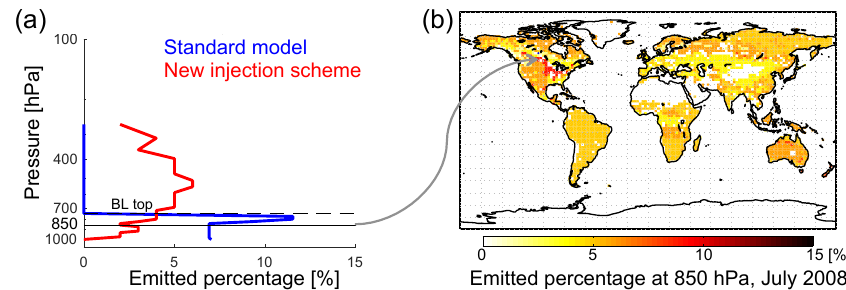
Figure 2. (a) Vertical profile of the percent of emissions in each model level for a sample location over boreal Canada (56 ◦ N, 105 ◦ W) from the public-release version of GEOS-Chem (blue) and the new observationally based injection scheme (red). The dashed line indicates the averaged boundary layer top of this month. The solid black line is at 850hPa, corresponding to the layer shown in (b) . (b) Percent of total-column biomass burning emissions emitted into the 850hPa layer in each model grid cell for July